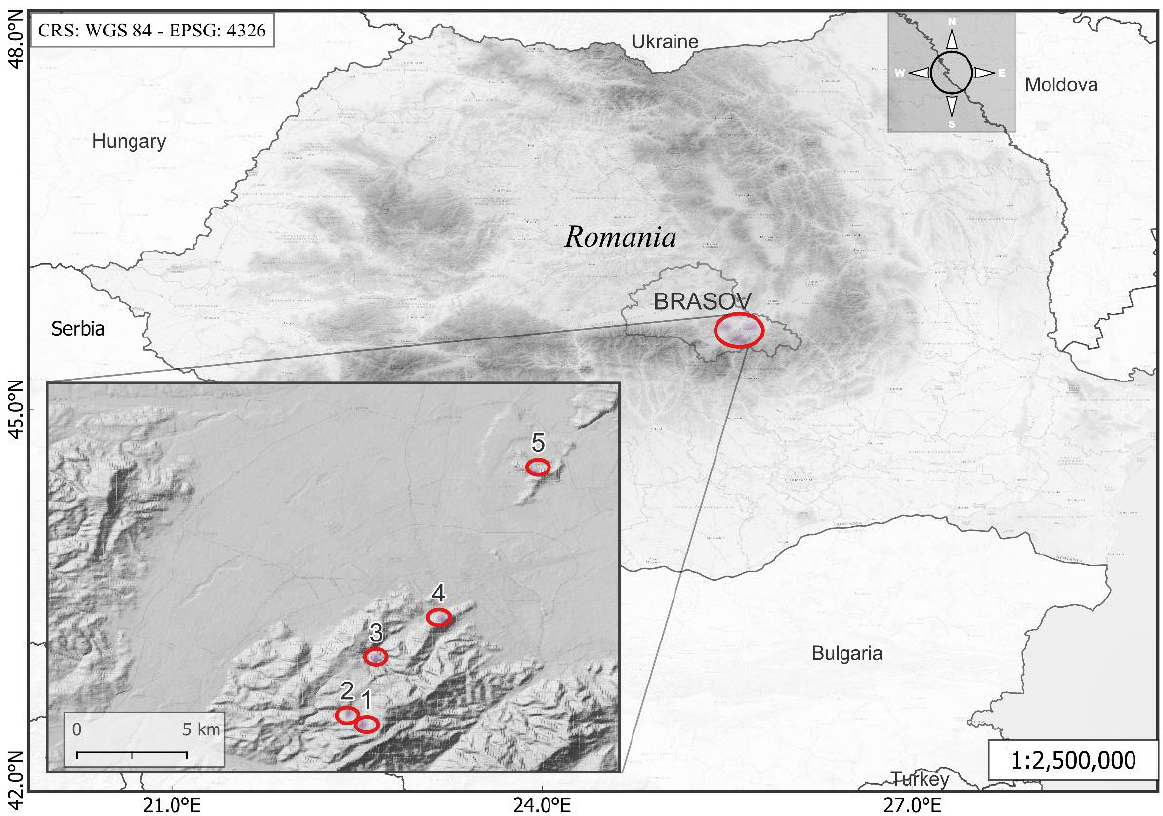
Figure 1. Topographic map of the study area in Brasov region, and the five sites, red circles across the altitudinal gradient (left-hand corner map). Study sites are numbered following Table 1.